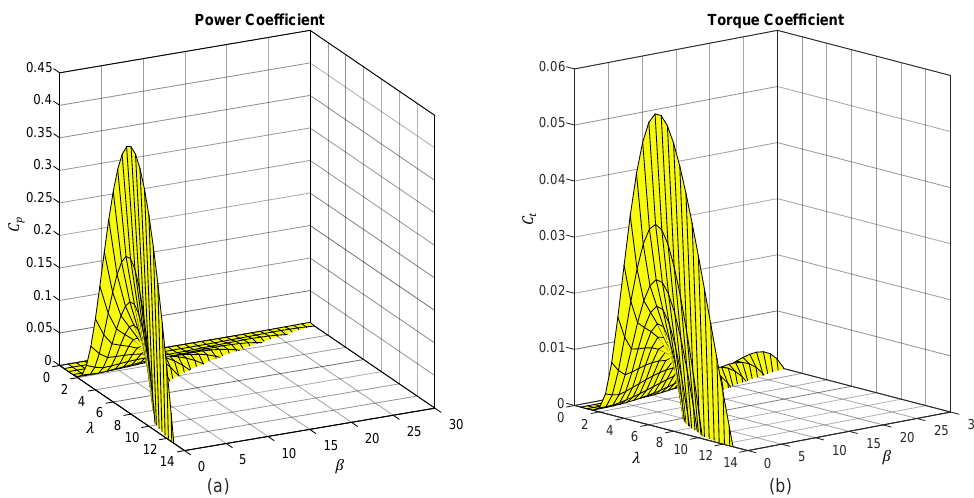
Figure 12. Coefficient proposed by Kotti, Janakiraman, and Shireen [30], with variations of 𝜆 and 𝛽 ; ( a ) power coefficient, ( b ) torque coefficient.